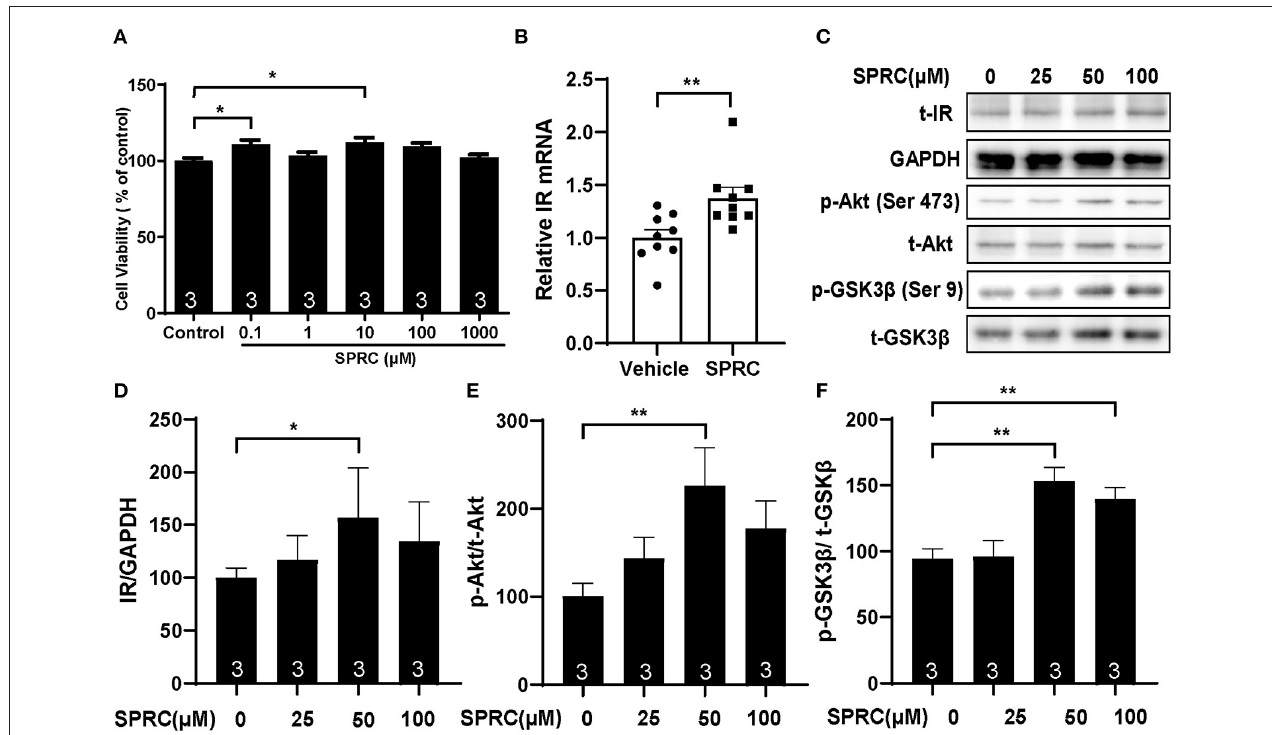
FIGURE 6 | SPRC treatment activated cardiac insulin receptor signaling in primary cardiomyocytes. (A) Primary mice cardiomyocytes were exposed to various concentrations of SPRC (0.1–1,000 µ M) for 24h. Cell viability was determined ( n = 3). * P < 0.05 vs. control group. (B) Primary mice cardiomyocytes were treated with 50 µ M SPRC for 24h. mRNA levels of insulin receptor ( Insr ) were determined by real-time qPCR. mRNA levels of Gapdh was used as reference for normalization ( n = 3). ** P < 0.01 vs. Vehicle group. (C–F) Primary mice cardiomyocytes were treated with vehicle or SPRC (25, 50, and 100 µ M) for 24h. The expression level of protein in insulin receptor signaling were determined by western blotting ( n = 3). * P < 0.05, ** P < 0.01 vs. Vehicle. Values are presented as means ±